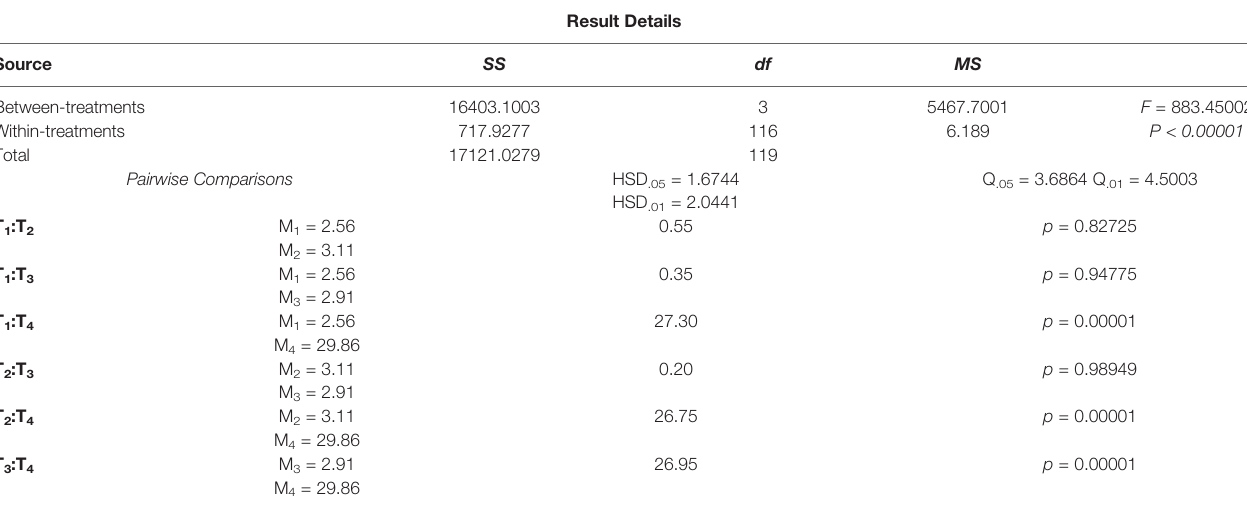
TABLE 2 | Summary of the data from the ANOVA analyzes and Post Hoc Tukey HSD test with DMT Modulus (elasticity).